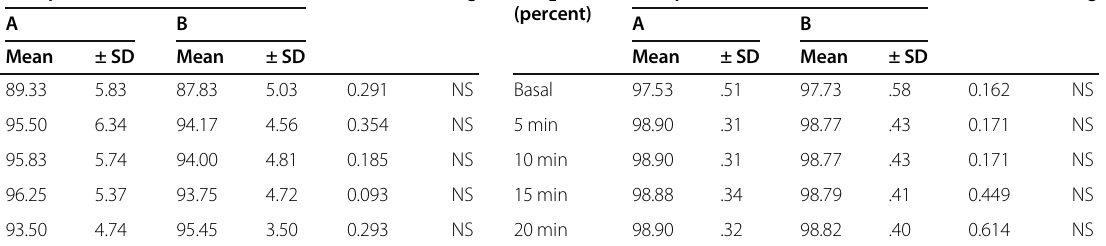
Table 2 Comparison between group A and B as regards MAP MAP Group P value (mmHg)